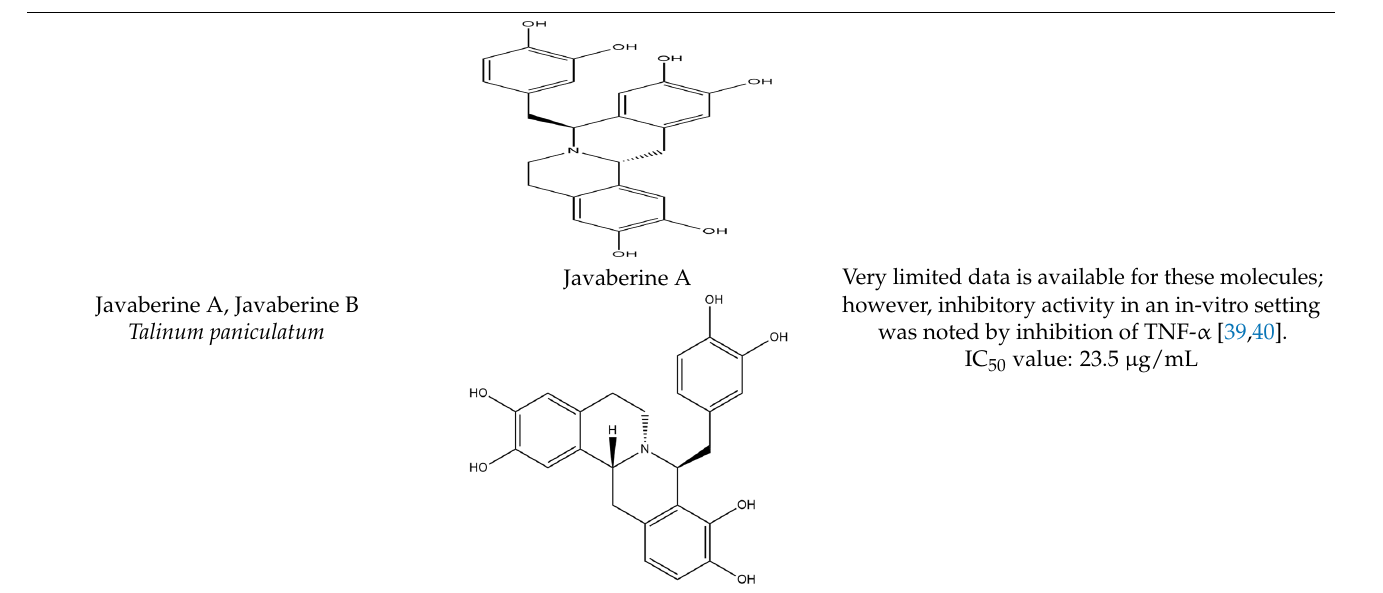
Table 1. Cont. Phytoconstituent (Alkaloids) Source Chemical Structure Mechanism of action